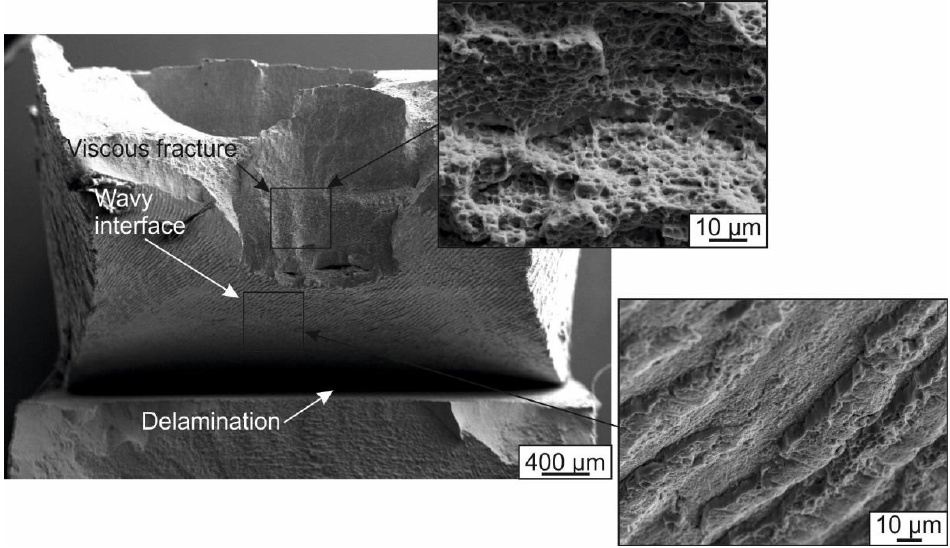
Figure 10. Fracture surfaces of VT23 – VT14 multilayered materials.